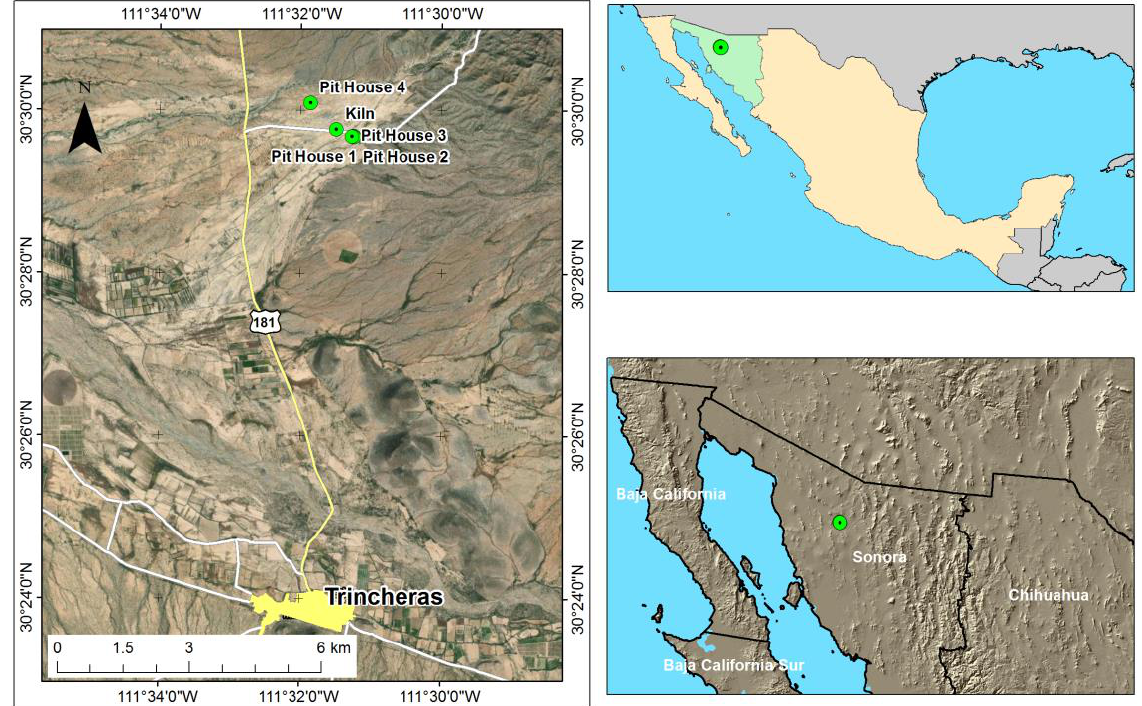
Figure 1. La Playa archaeological site in the municipality of Trincheras, State of Sonora, Mexico showing the locations of Pit Houses and Kiln ( Horno ). The data are obtained from INEGI (INSTITUTO NACIONAL DE ESTADISITICA E GEOGRAFIA), while ArcMap was used to draw schematic maps.